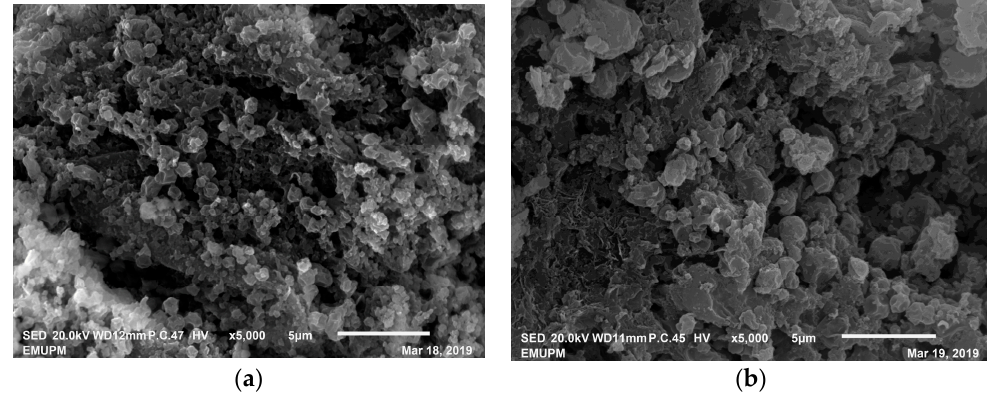
Figure 8. SEM images of CLEA–elastase ( a ) and CLEA–elastase–SB ( b ). Both images were taken under 5000× magnification. 5000 ×